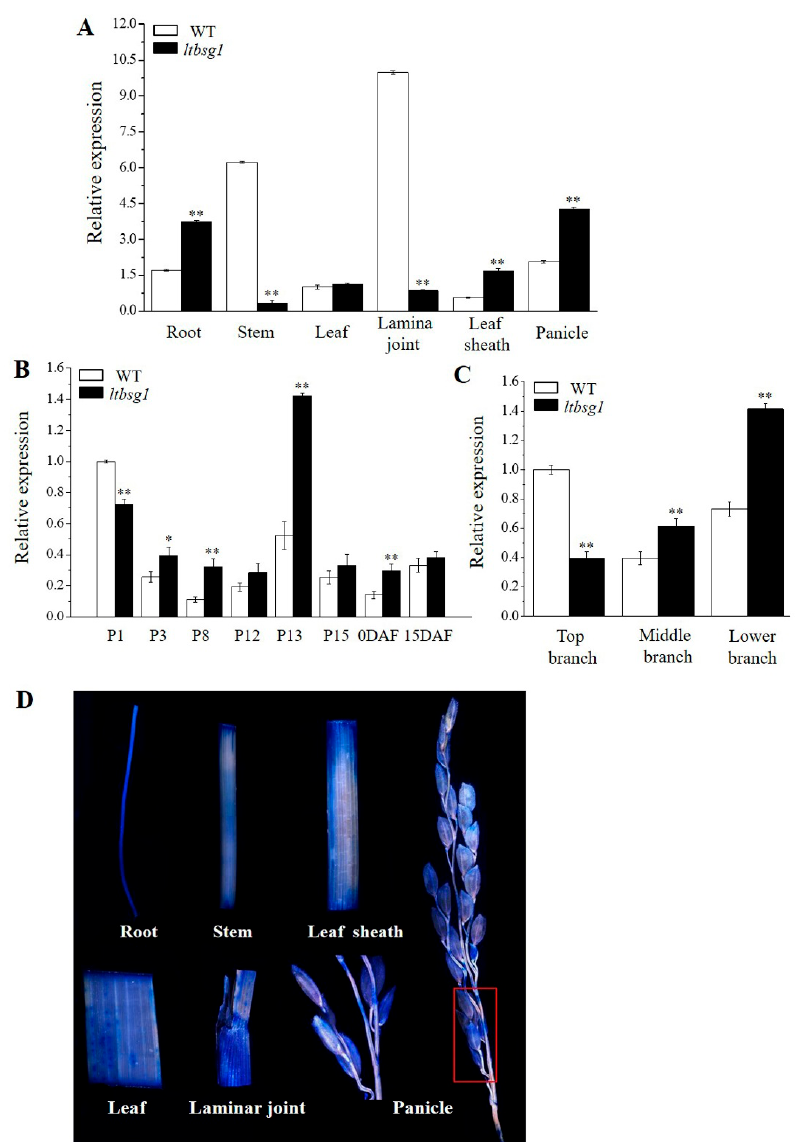
Figure 6. Expression pattern analysis of LTBSG1 . ( A ) Temporal and spatial patterns of LTBSG1 gene in WT and mutant ltbsg1 at heading stage; ( B ) LTBSG1 gene expression in panicles of 1 cm (P1) to 15 cm (P15), flowering day (0DAF) and 15 days after fertilization (15DAF); ( C ) The expression of LTBSG1 in different branches of young panicle in WT and mutant ltbsg1 ; ( D ) β -glucuronidase (GUS) assay staining analysis of the LTBSG1 promoter in different tissues. The red box in panicle was magnified. The rice OsActin gene was used as an internal control. Values represent the means ± SD of three biological replicates ( n = 3). * p < 0.05; ** p < 0.01.